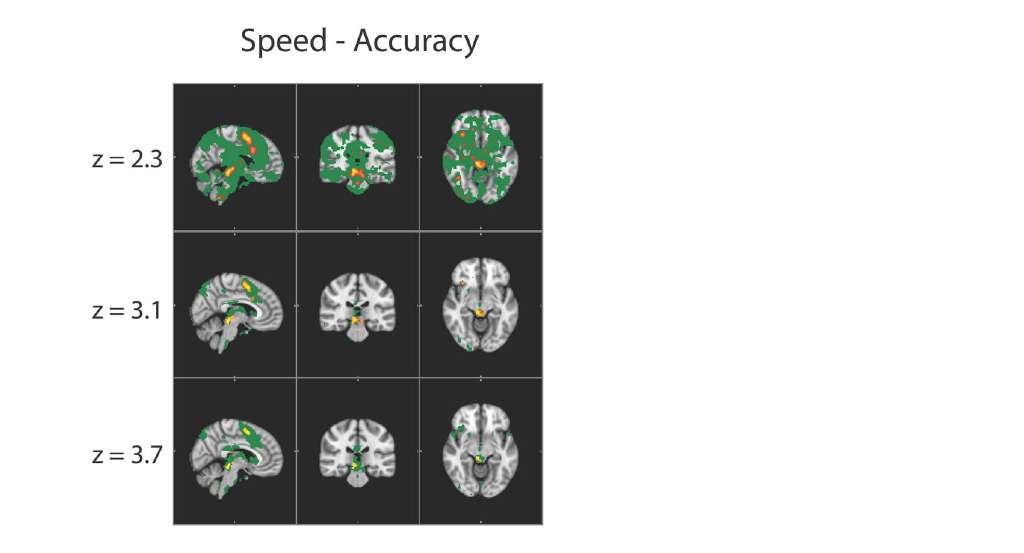
Fig. 5. Results of the in limbo approach on actual fMRI-data from Forstmann et al. [19], using different z-thresholds of 2.3, 3.1 and 3.7, corresponding to uncorrected single-sided a -values of p , 0.01, p , 0.001 and p , 0.0001. After this initial thresholding procedure, these surviving areas were corrected at the cluster-level using Gaussian random field theory. The in limbo areas are not significantly different from the least-significantly activated brain area, according to a t-test with an alpha-level of p , 0.05, uncorrected for multiple comparisons. Legend: Yellow-red areas are significantly activated, green areas are in limbo. Note how with a rather liberal threshold of 2.3 almost the entire brain is in limbo and increasing the z-threshold from 3.1 to 3.7 does not change much in volume of brain that is in limbo. Brains are in MNI-152 space with slices at X 5 42, Y 5 65, Z 5 65.